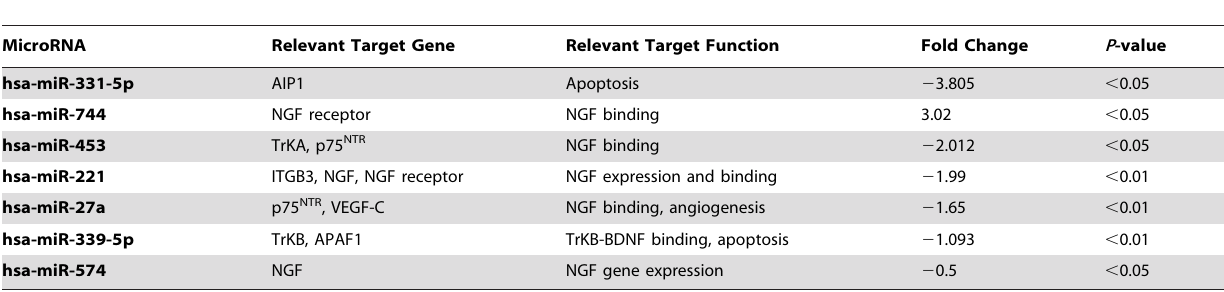
Table 1. RSV-induced Changes in the Expression of MicroRNAs Predicted to Target Neurotrophic Pathways.